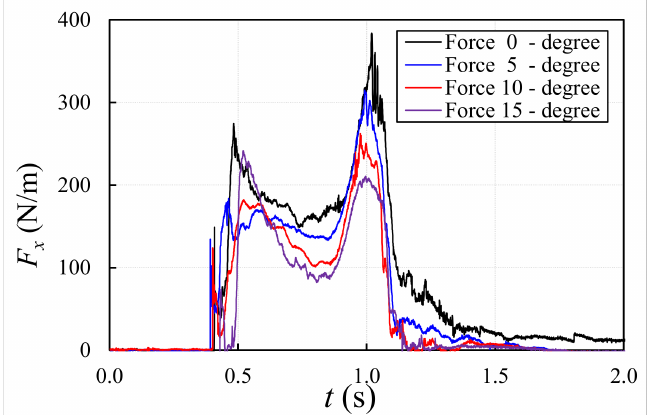
Figure 10. Time-history of the impact force obtained from the integration of the experimental dynamic pressure.